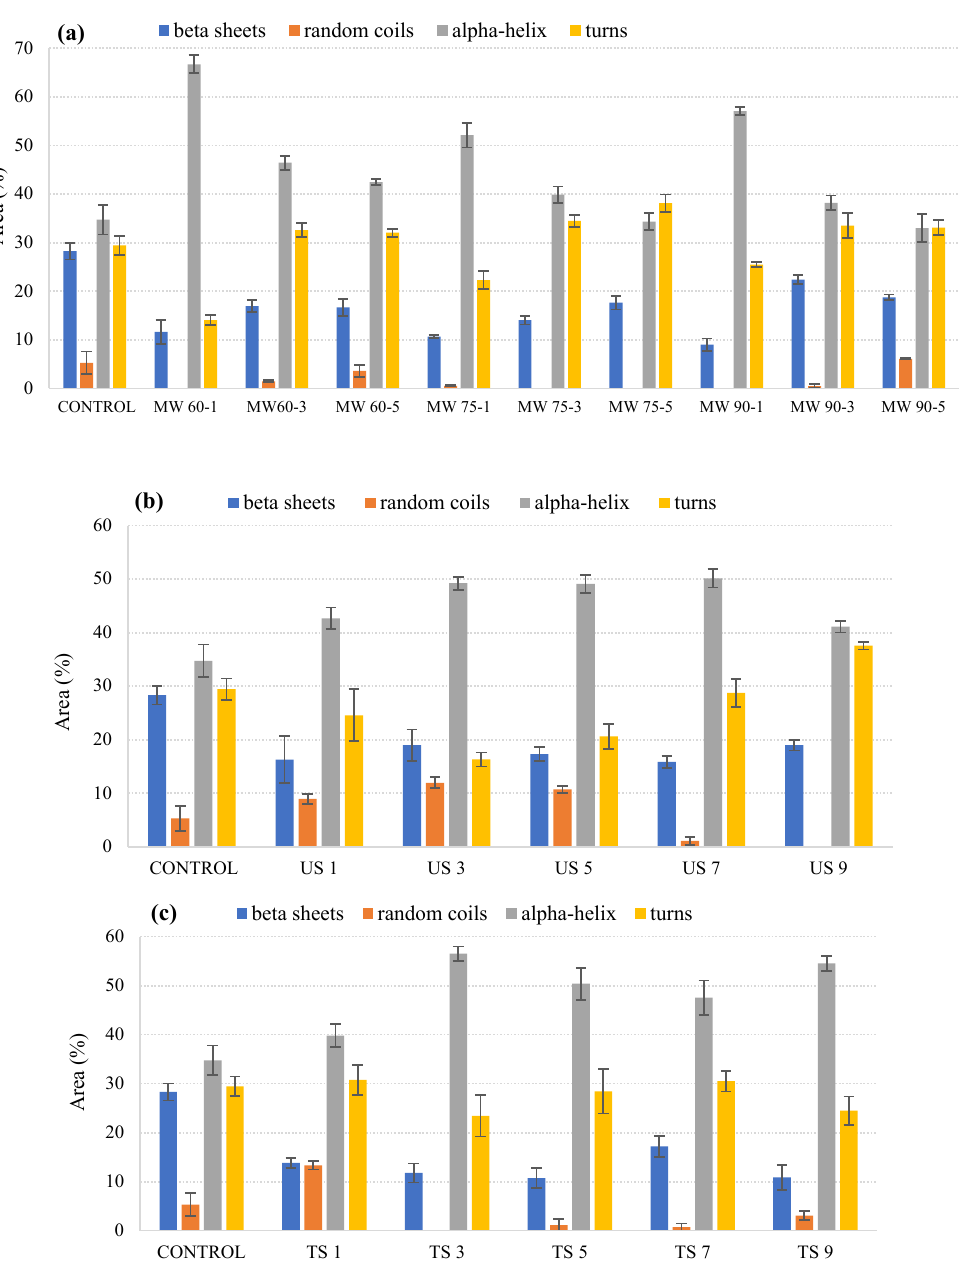
Figure 1. Variations in relative areas of the bands fitted to the normalized FTIR spectra of the Amide I region (1700–1600 cm –1 ) of microwave-processed ( a ), ultrasound-processed ( b ), and thermosonication-processed ( c ) cow milk. Note: the error bar means standard error of the mean.